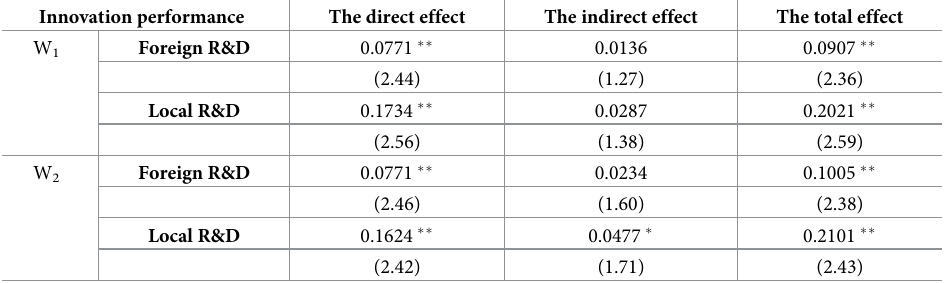
Table 6. Decomposition of direct effect, indirect effect and the total effect of the SAR